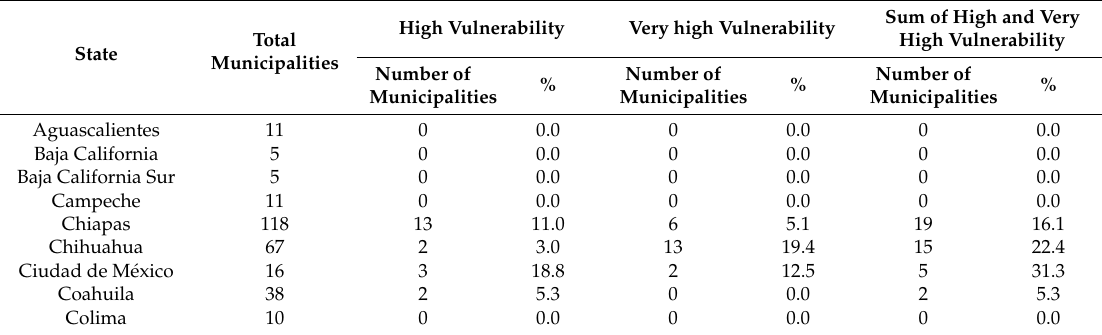
Table A2. Social vulnerability. Number of municipalities by state and percentages of municipalities with high and very high social vulnerability by